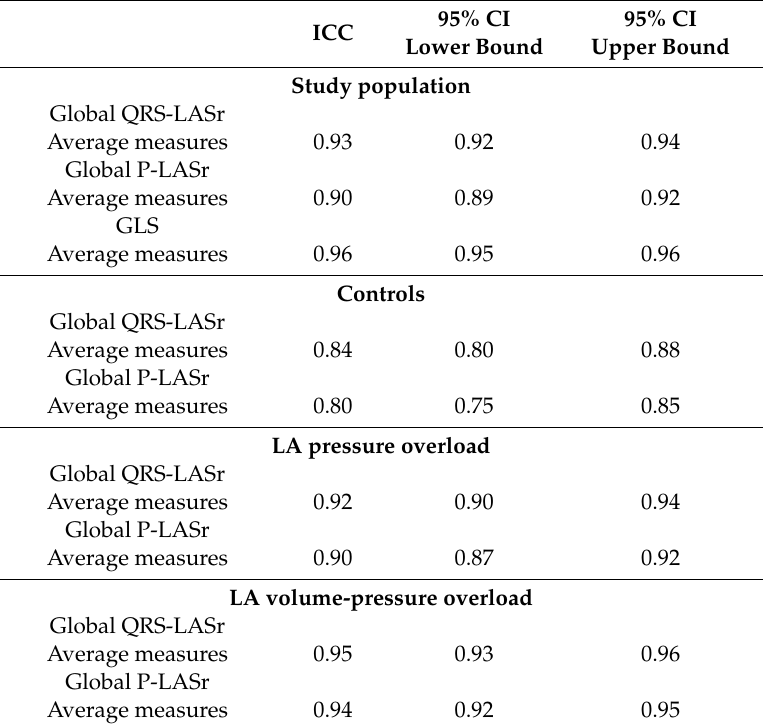
Table 4. Intraclass Correlation Coe ffi cient (ICC).